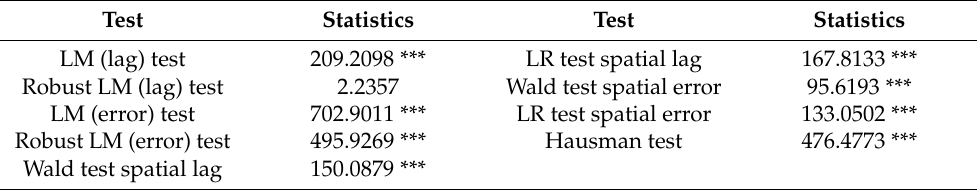
Table 7. Spatial model test results under the economic distance spatial weight matrix.